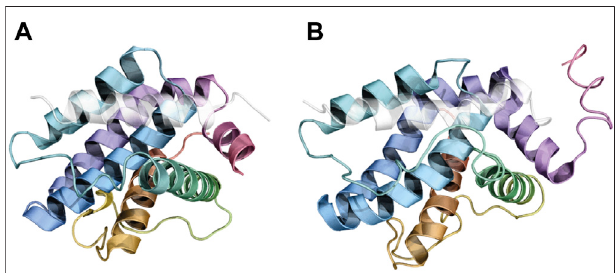
FIGURE6 | Conformationalchangesin helix ɑ 3ofBCLXLinducedupon BH3 binding. BCLXL is displayed in rainbow colors in both panels, while the BH3 peptide is colored light gray and semitransparent. The helix ɑ 3 is shown ingreen. Inpanel (A) ,thecomplexbetweenBCLXLandtheBH3motifof BECN1 shows a folded ɑ -helix (PDB ID: 2PON), while a partial unfolding is observed in panel (B) , in the complex between the BCLXL and the BH 3 of PUMA (PDB ID: